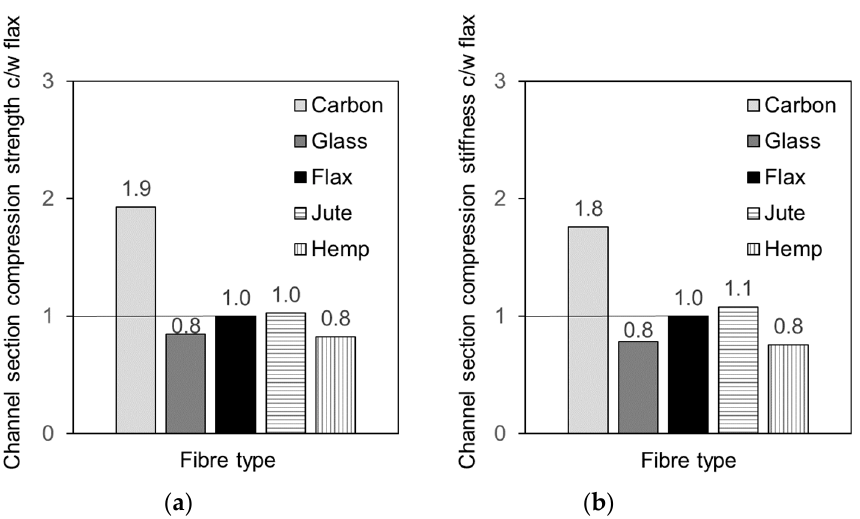
Figure 10. Mean compression strength and stiffness efficiency of structural columns from channel tests: ( a ) strength and ( b ) compression stiffness (EA/L, where E is the elastic modulus, A is the cross-section area, and L is the channel length), compared with the values for flax.